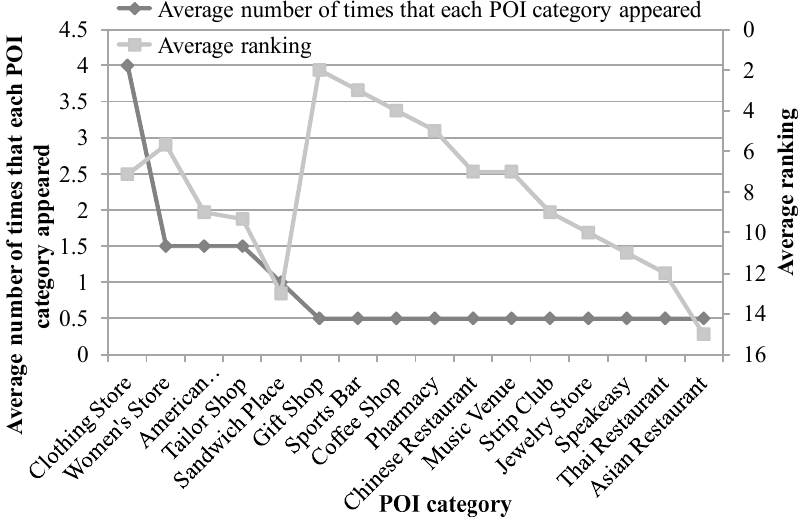
Figure 14. Average results of queries based on the 2 dry cleaners.